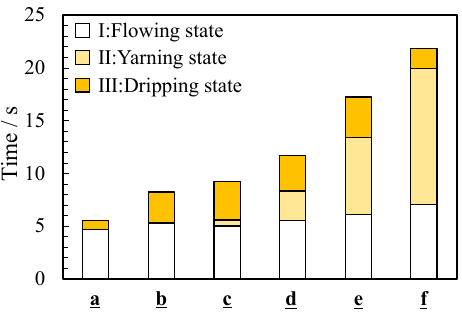
Figure 6. Average time for three states during pouring: (I) flowing state, (II) yarning state, and (III) dripping state.